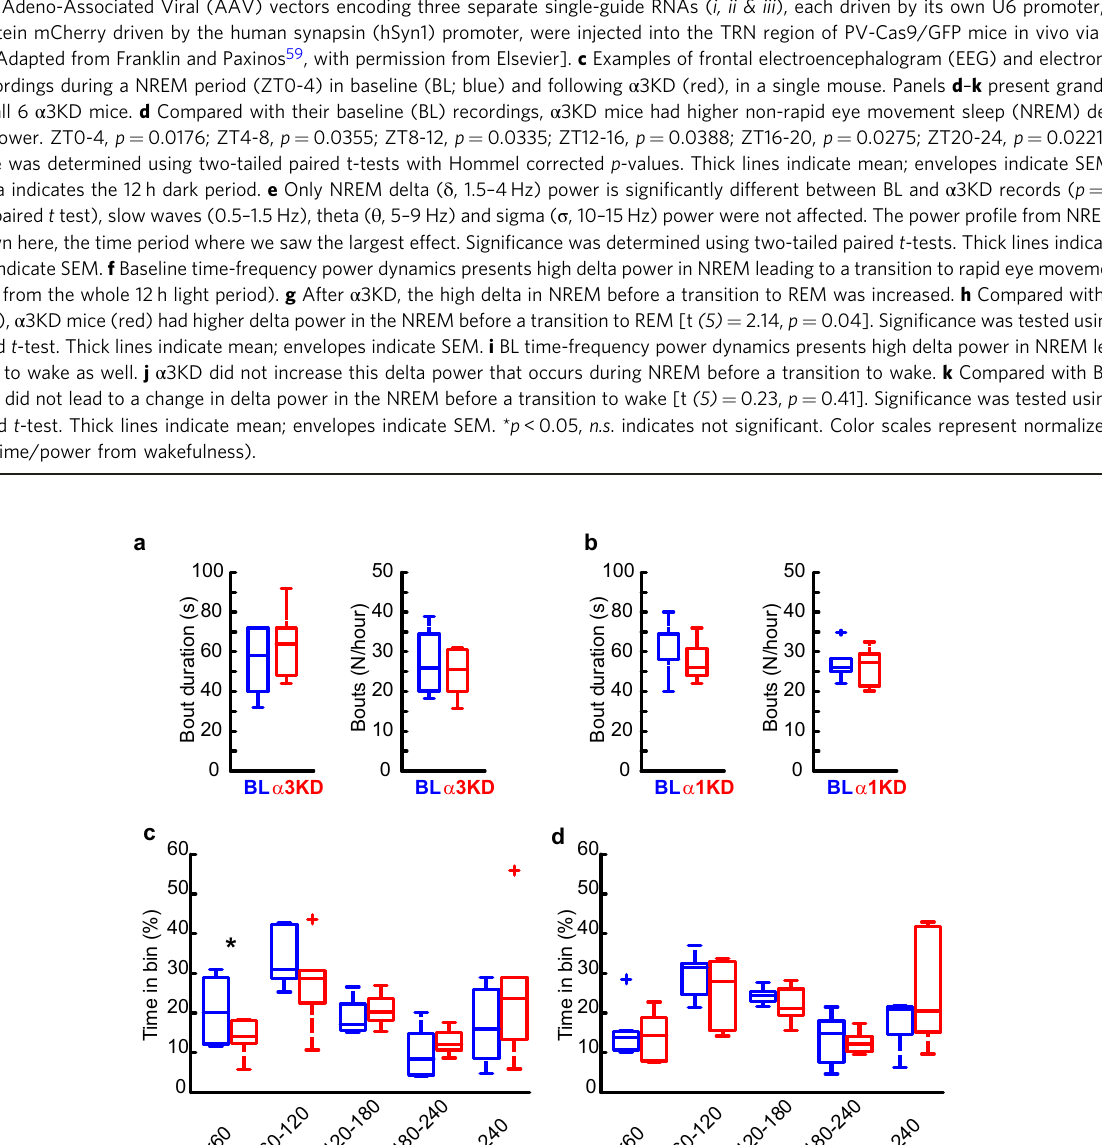
Fig. 1 α 3KD in PV + TRN neurons increased NREM 1.5 – 4 Hz delta power, especially at NREM to REM transitions. a The γ -amino butyric acid receptor type-A (GABA A R) is a pentameric heteromeric ion channel. CRISPR-Cas9 abscission was directed to three locations (insertion/deletion; INDEL sites) of the gene which correspond to the large extracellular region of the α 3 subunit, a necessary structural as well as ligand binding component in GABA A Rs of the TRN. b Adeno-Associated Viral (AAV) vectors encoding three separate single-guide RNAs ( i, ii & iii ), each driven by its own U6 promoter, and the marker protein mCherry driven by the human synapsin (hSyn1) promoter, were injected into the TRN region of PV-Cas9/GFP mice in vivo via guide cannulas. [Adapted from Franklin and Paxinos 59 , with permission from Elsevier]. c Examples of frontal electroencephalogram (EEG) and electromyogram (EMG) recordings during a NREM period (ZT0-4) in baseline (BL; blue) and following α 3KD (red), in a single mouse. Panels d – k present grand average